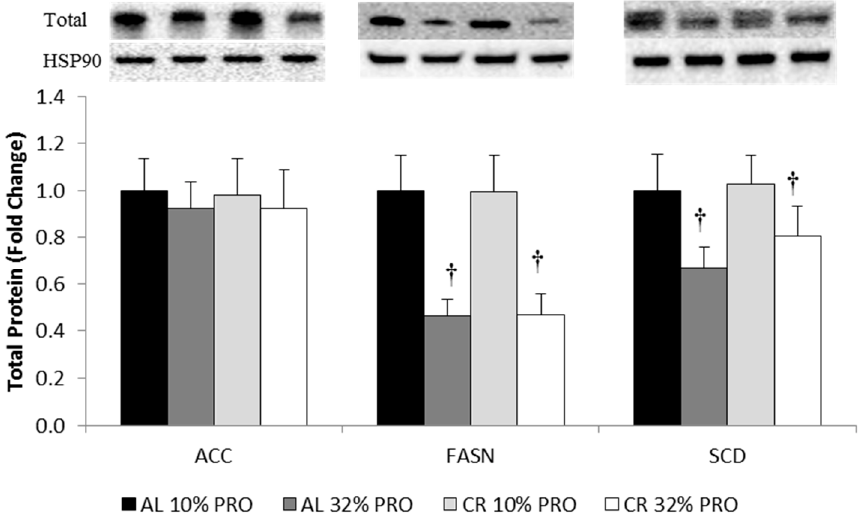
Figure 3. Total protein expression of lipogenic regulators relative to AL 10% PRO, normalized to HSP90. Values presented as mean ± SEM. † Main effect of protein, 32% PRO different than 10% PRO; p < 0.05. HSP90: heat shock protein 90.